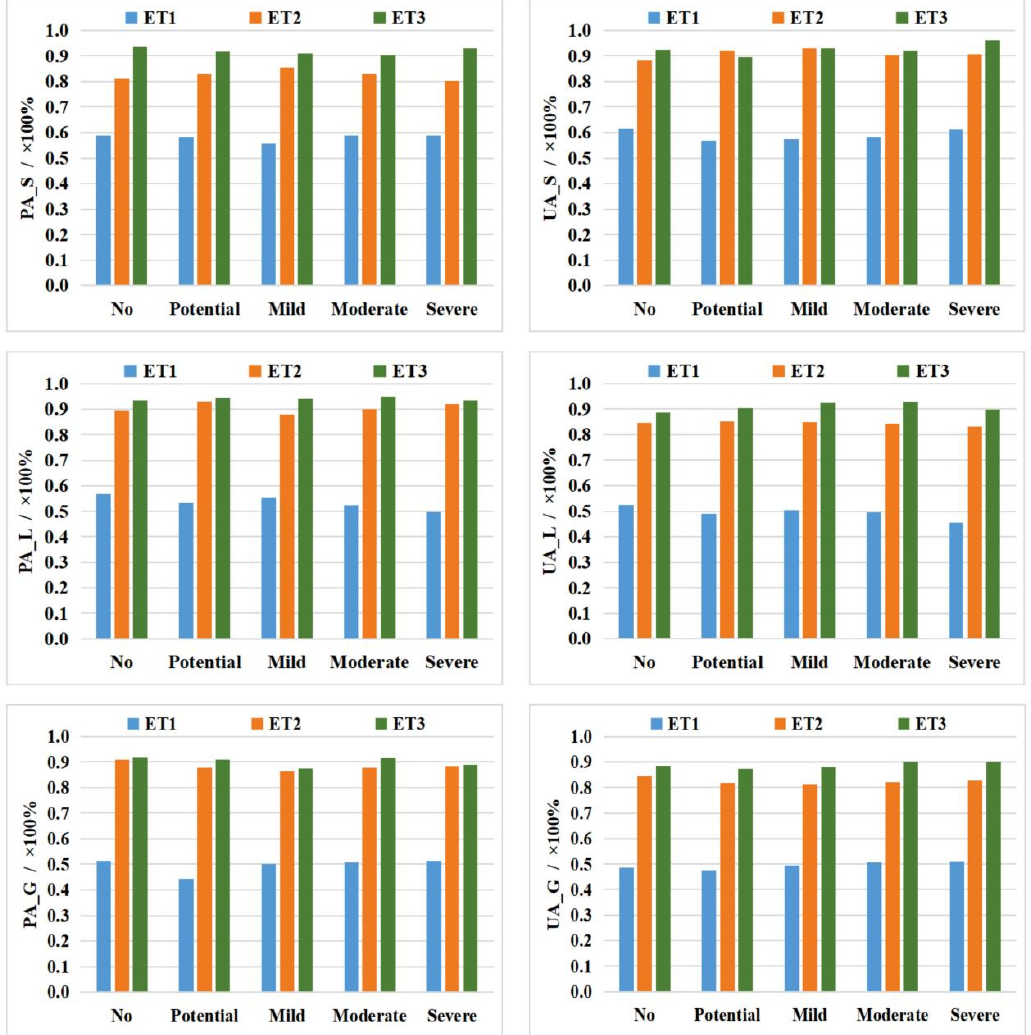
Figure 6. Producer’s accuracy (PA) and user’s accuracy (UA) for extraction results of different levels of rocky desertification (“S”, “L”, and “G” represent three types of images of Sentinel-2B, Landsat-8, and Gaofen-6.).